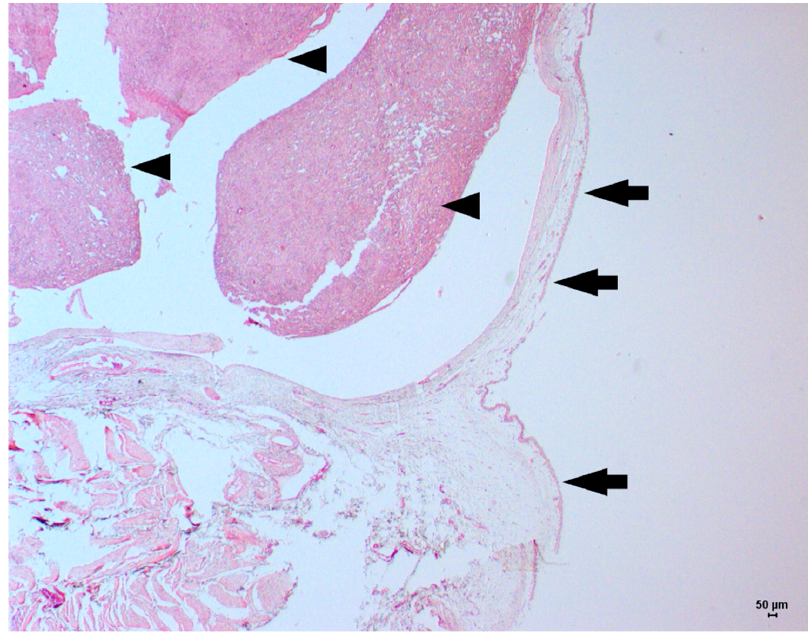
Figure 2. Low-power magnification view of a feline bladder leiomyosarcoma. The intact urothelial epithelium in the bladder mucosa (black arrows) and the fusiform tumor cells growing in the bladder submucosa (arrowhead) can be observed. Hematoxylin and eosin staining, original magnification 2.5×.